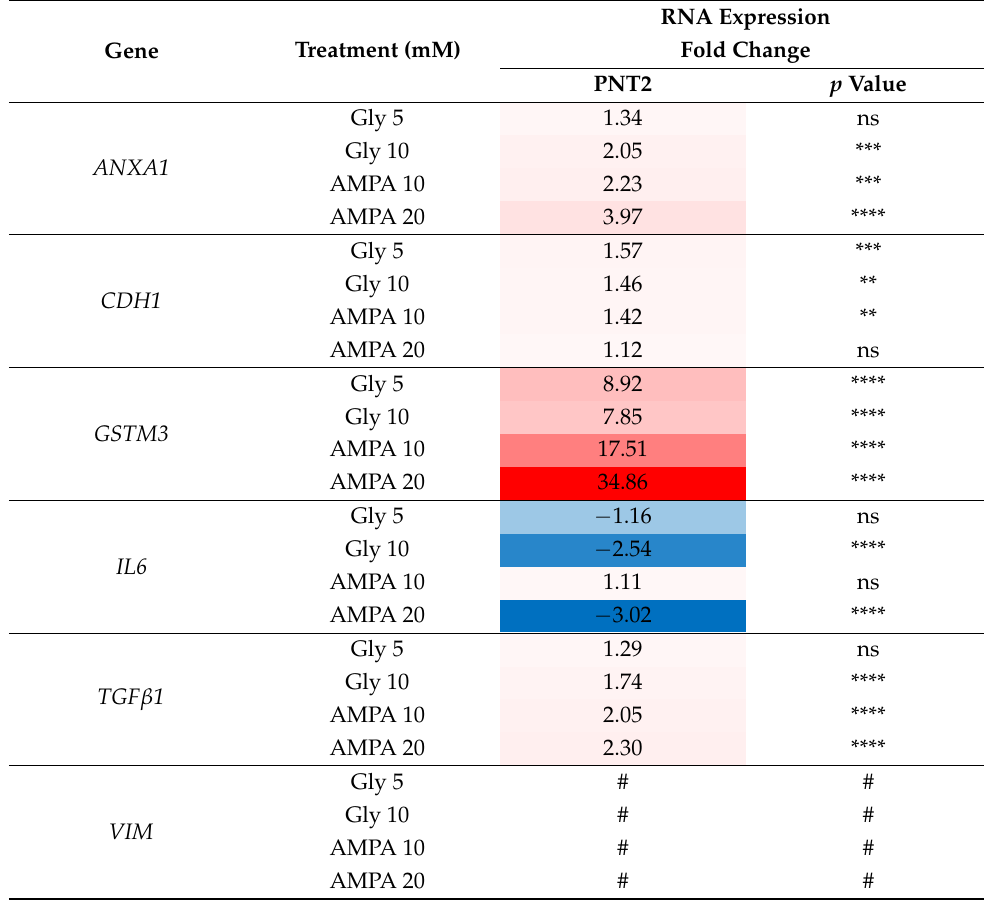
Table 2. Fold change in expression levels of mRNAs of different biomarkers in PNT2 (prostate, non-tumorigenic cells). Treatments were compared to untreated cells (control). Three independent experiments were performed (n = 3) in